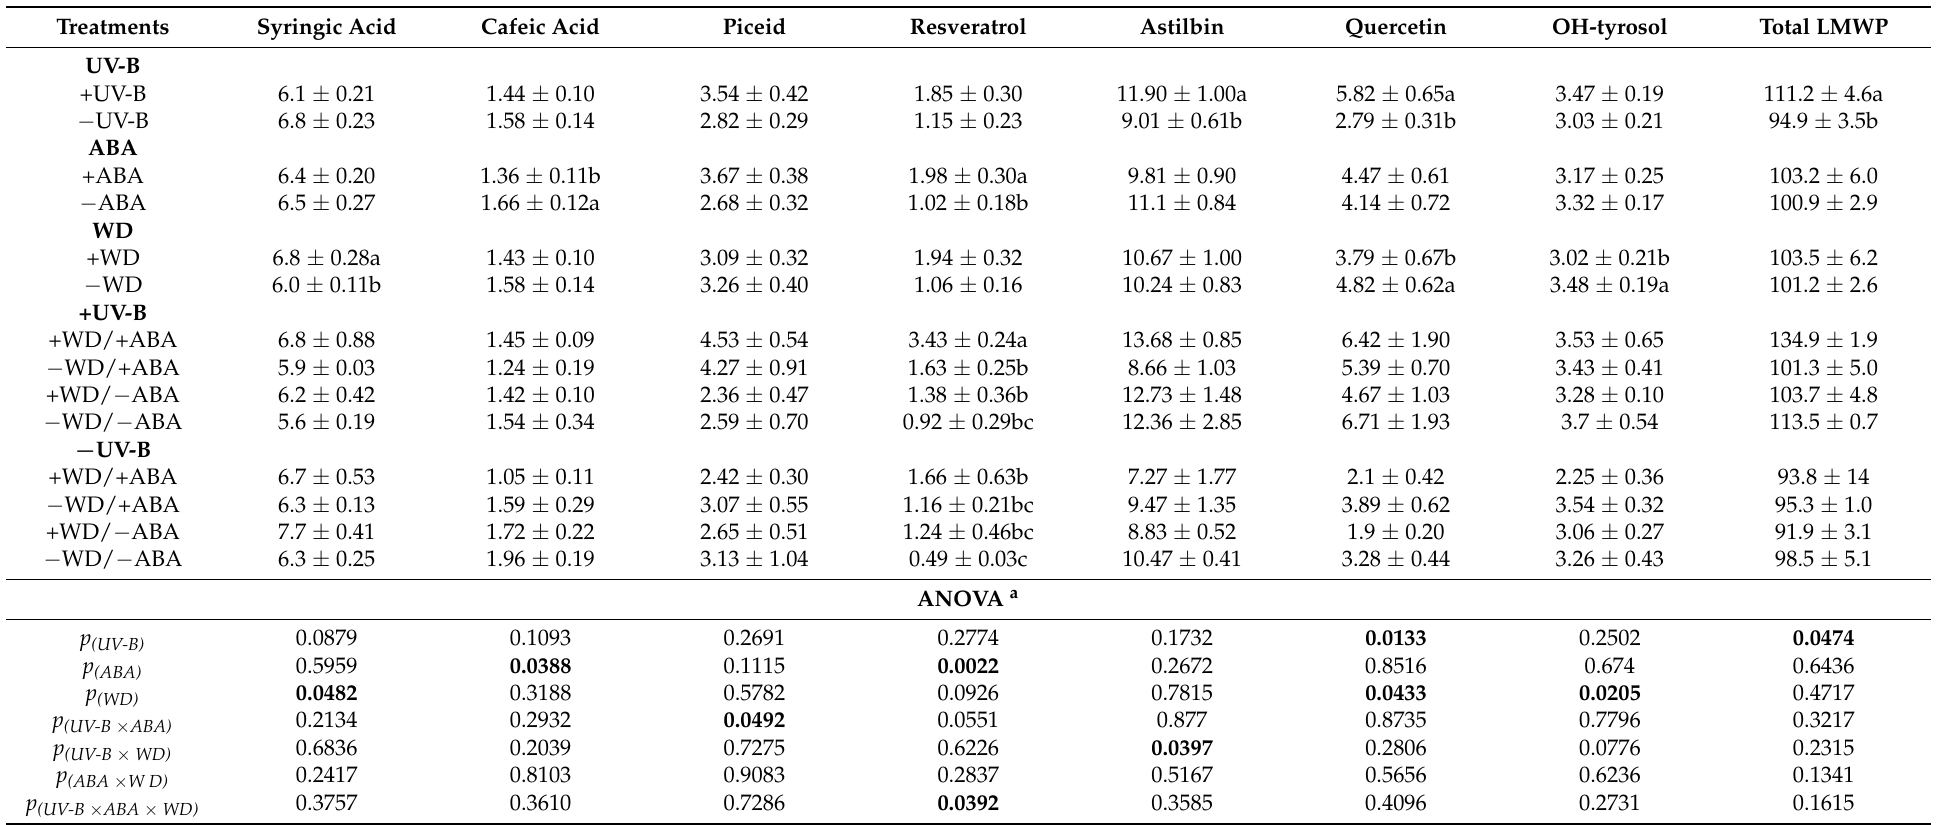
Table 1. Low molecular weight phenolic (LMWP; mg L − 1 ) determined in wines from Malbec plants exposed to combined UV-B, WD and ABA treatments.